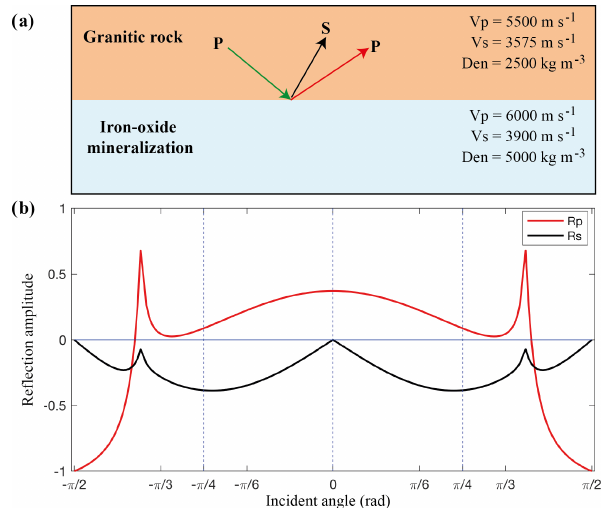
Figure 12. (a) A two-layer model with rock properties of granitic rock in the top layer and that of iron oxide mineralization in the bot- tom layer. (b) The amplitude versus incident angle (AVA) response of the reflected P and S waves. The incident plane wave is a P wave with amplitude